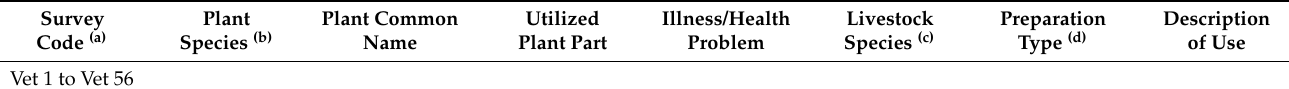
Table A1. Survey